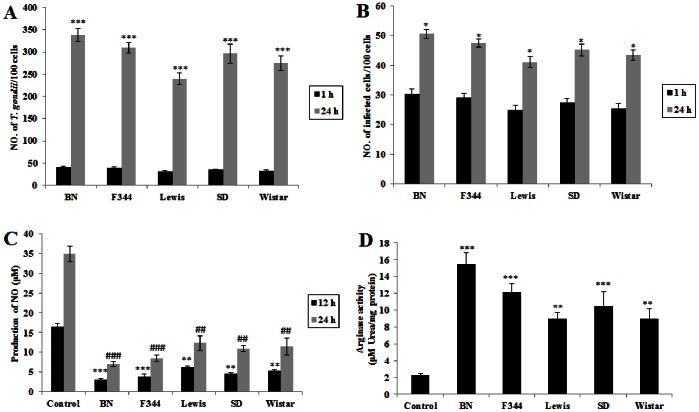
Growth status, production of NO and arginase activity of T. gondii in alveolar macrophages isolated from different strains of rats (BN, F344, Lewis, SD and Wistar).Rat alveolar macrophages (RAMs) were incubated with T. gondii at the ratios of 1∶1 (parasite/macrophages = 1∶1), then the extracellular T. gondii (the non-invaded individuals) were washed from the medium and the time was defined as 1 hr. The infection results were observed by fluorescence microscopy. (A) Comparison of number of T. gondii per 100 cells. (B) Comparison of number of infected cells per 100 cells. Data in A and B represents a mean ± SEM calculated from 3 independent experiments performed in triplicate. Probabilities *p<0.05 and ***p<0.001, (ANOVA), show significant differences from the infection at 1 hr of each type of macrophage respectively. (C) NO production of different rat alveolar macrophages was measured by the Griess reaction. Data represent a mean ± SEM calculated from 3 independent experiments performed in triplicate. Probabilities **p<0.01 and ***p<0.001, (ANOVA), show significant differences from NO production of control (RPMs cultured for 12 h); probabilities ##
p<0.01 and ###
p<0.001, (ANOVA), show significant differences from NO production of control (RPMs cultured for 24 h). Control: SD rat peritoneral macrophage. (D) Arginase activity of different rat alveolar macrophages were measured by a colorimetric assay (enzyme activity is the output of urea secreted from lysed macrophages). Data represent mean ± SEM calculated from 3 independent experiments performed in triplicate. Probabilities **p<0.01 and ***p<0.001, (ANOVA), show significant difference from control (SD rat peritoneal macrophages).